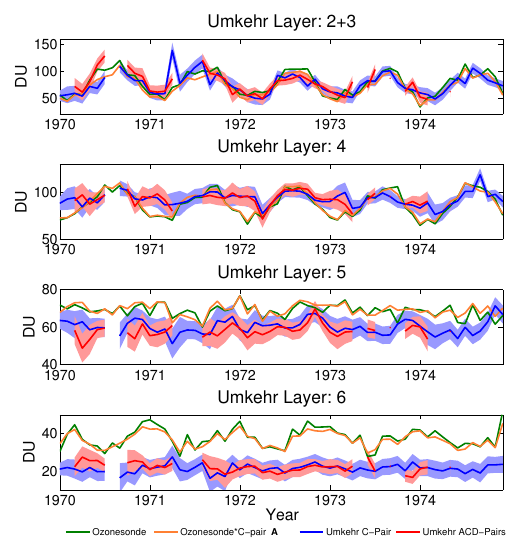
Figure 5. Time series of Umkehr partial columns, in Dobson units, compared to coincident ozonesondes layers. The C-pair A con- volved ozonesonde data were combined with a climatology of upper level ozone from the vertically resolved ozone database. Shading on Umkehr curves shows retrieved one standard